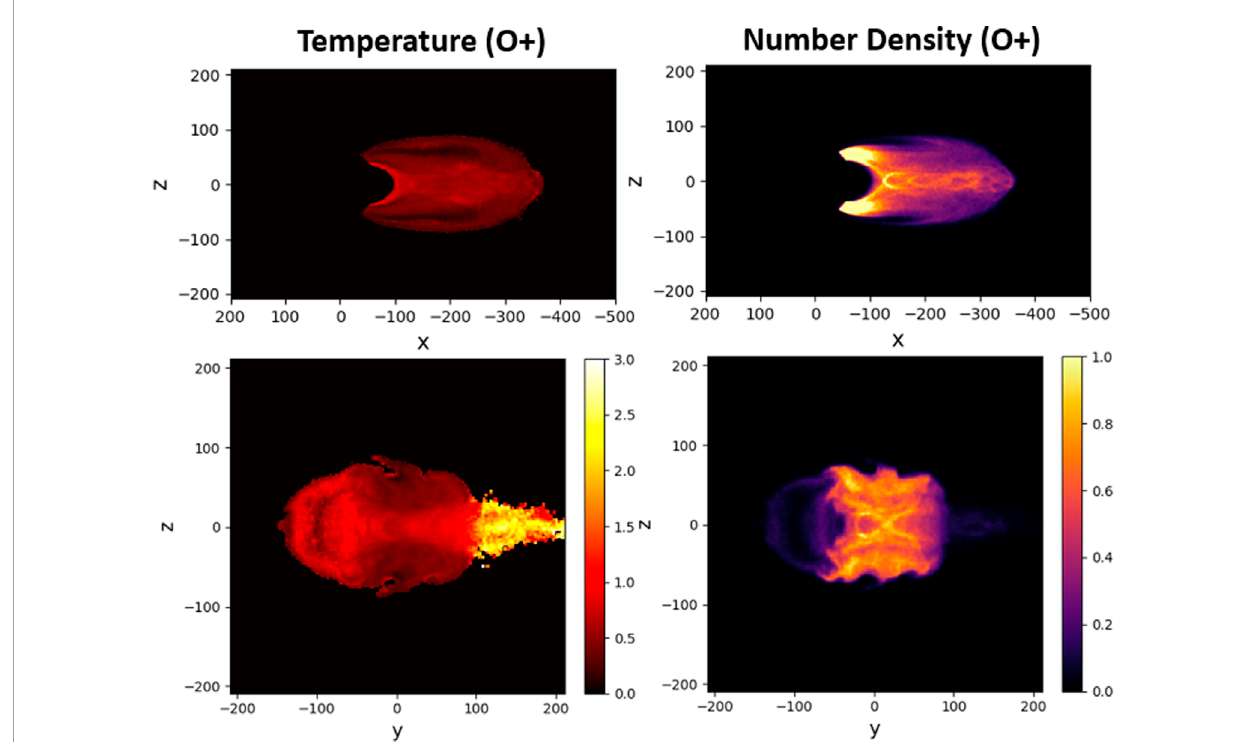
FIGURE 8 O+ temperature and number density in two cross-sections in the auroral outflow simulation at Ω cp t = 461: x–z ( y = 1 d i ) and y–z ( x = − 119 d i ) .